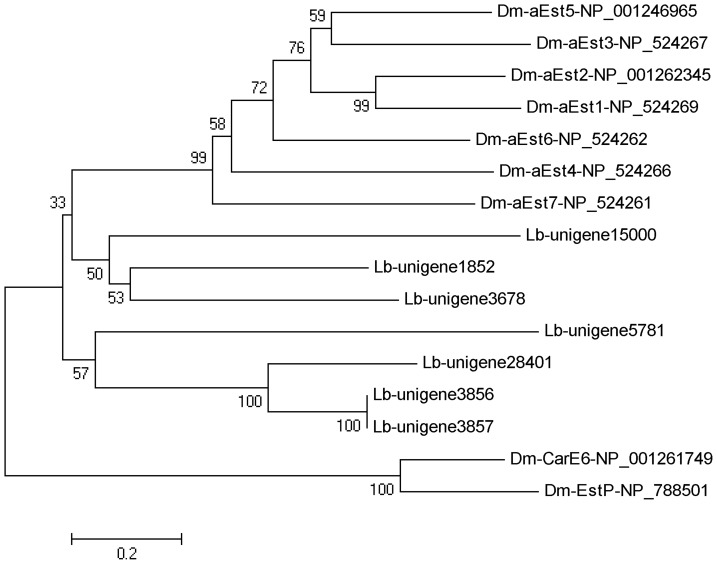
Phylogenetic tree of carboxylesterases from Liposcelis bostrychophila (Lb) and Drosophila melanogaster (Dm).The tree was constructed from the multiple alignments using MEGA 5.0 software and generated with 1,000 bootstrap trials using the neighbor-joining method. The numbers indicate the bootstrap confidence values obtained for each node after 1,000 repetitions.